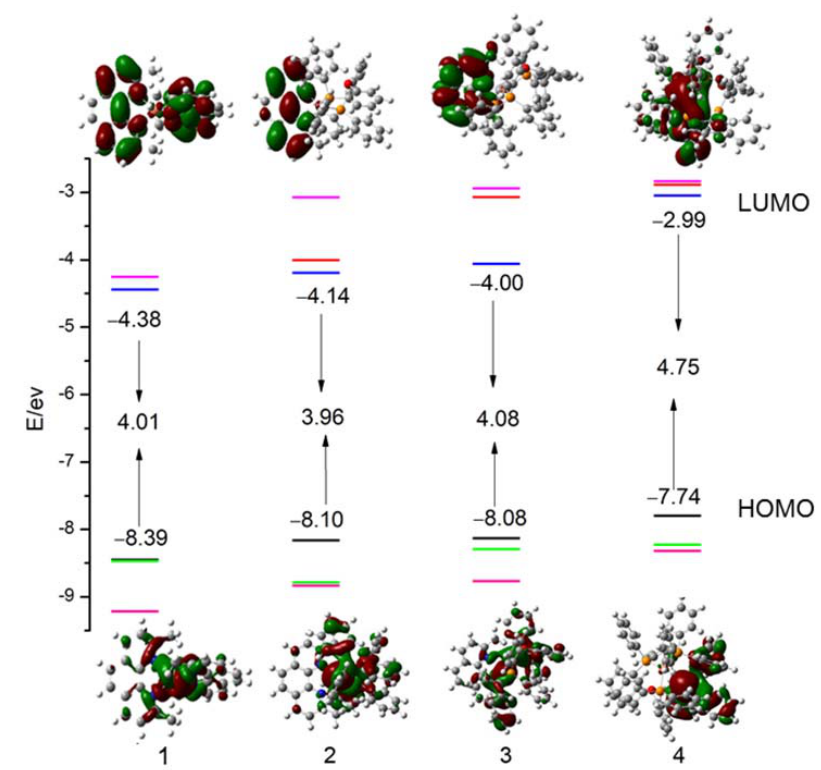
Figure 3. Frontier molecular orbital energy levels, the energy gaps ∆ E H-L and the electronic density contours of the frontier molecular orbital in the S 0 state for studied complexes.